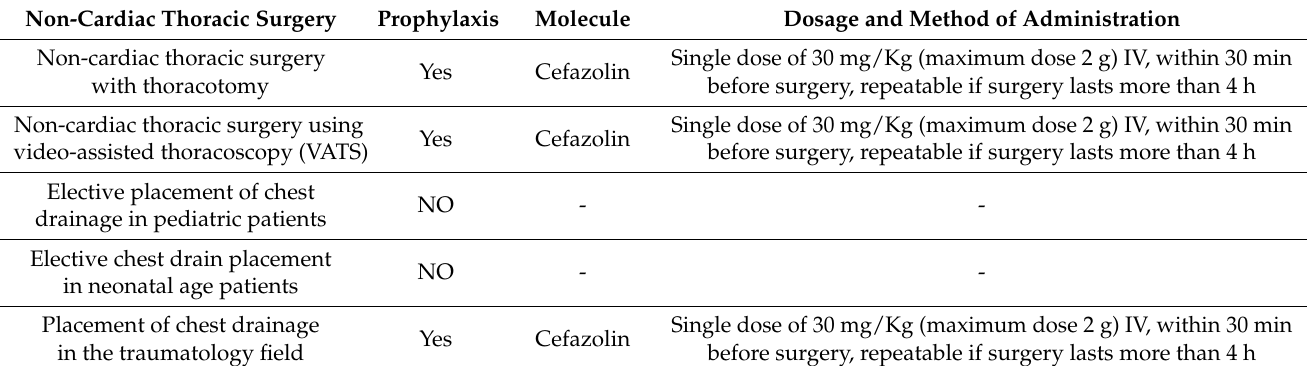
Table 5. Summary of recommendations for thoracic